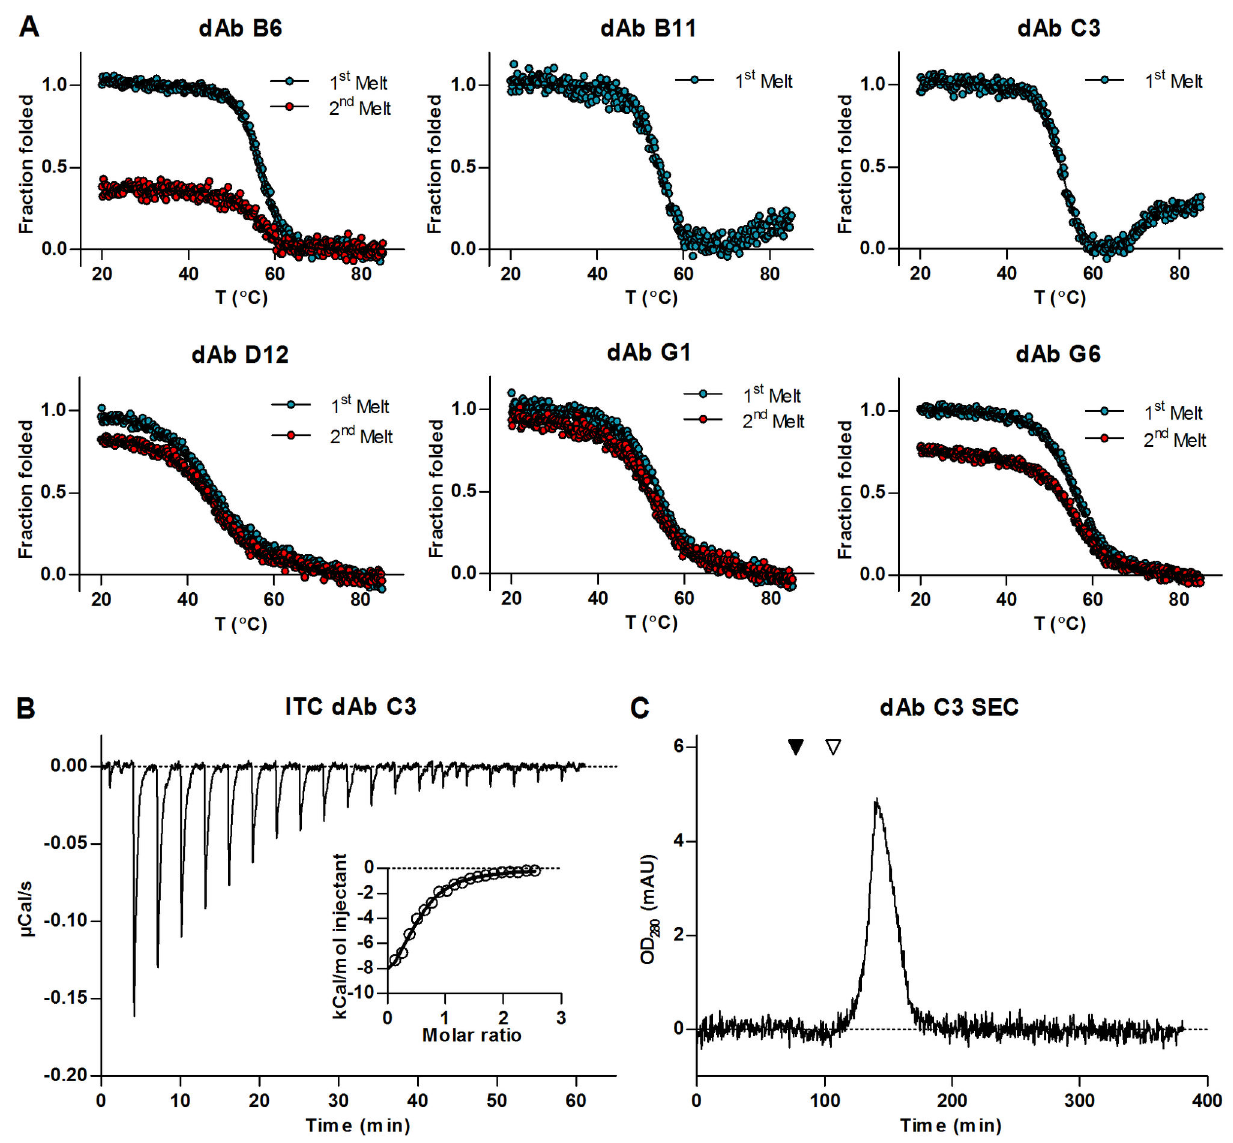
Figure 7. Biophysical evaluation of isolated antibodies and affinity measurement for C3 against hen egg lysozyme. ( A ) Thermal unfolding and refolding for the lysozyme binding clones assayed by circular dichroism spectroscopy. The first melting curve for each clone is shown in blue, and the subsequent melting curve in red. After recording the first melting curve the antibodies were allowed to cool, and the experiment was repeated using the refolded antibodies. ( B ) Recorded heat change over time during successive injections of lysozyme into the cell containing C3 domain antibody. The insert shows the integrated injection heats as a function of molar ratio of the lysozyme to the antibody. Circles are the integrated signal from the larger panel, and the best fit of the 1:1 binding equation to the observation is shown as a line. The figure is representative for the three measurements performed. ( C ) Chroatogram from size exclusion chromatography of C3 antibody. The migration of two size markers is shown in the chromatogram; albumin (black triangle) with a size of 66 kDa, and TEV-protease (white triangle) with a size of 26 kDa. The single elution peak of the antibody well below the 26 kDa reference protein indicates that it exhibits a monomeric state in solution.